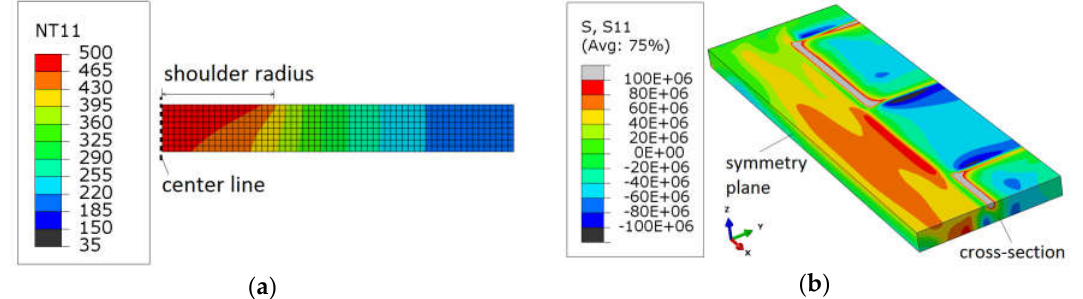
Figure 7. Illustration of sources influencing the cross-sectional longitudinal residual stress field from the manufacturing process. ( a ) Contour plot of the temperature (°C) from the numerical simulation with the specimen cut in half just after the heat source has passed the centerline; ( b ) Contour plot of the longitudinal stress field (Pa) after the FSW process but before cooling down and release of the constraining boundary conditions.